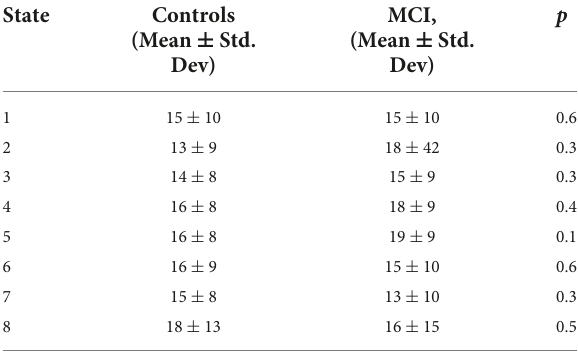
TABLE 2 Comparison of Dwell times between controls and mild cognitive impairment (MCI) 1 .